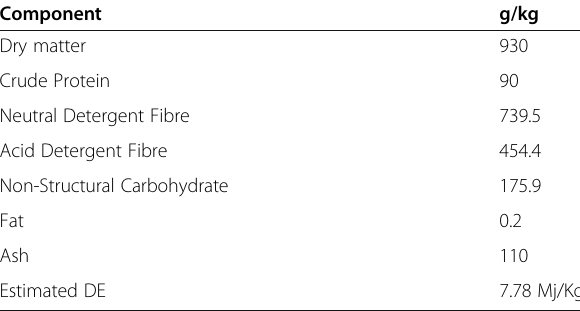
Table 3 Chemical composition of the Timothy hay used as the substrate for in vitro gas